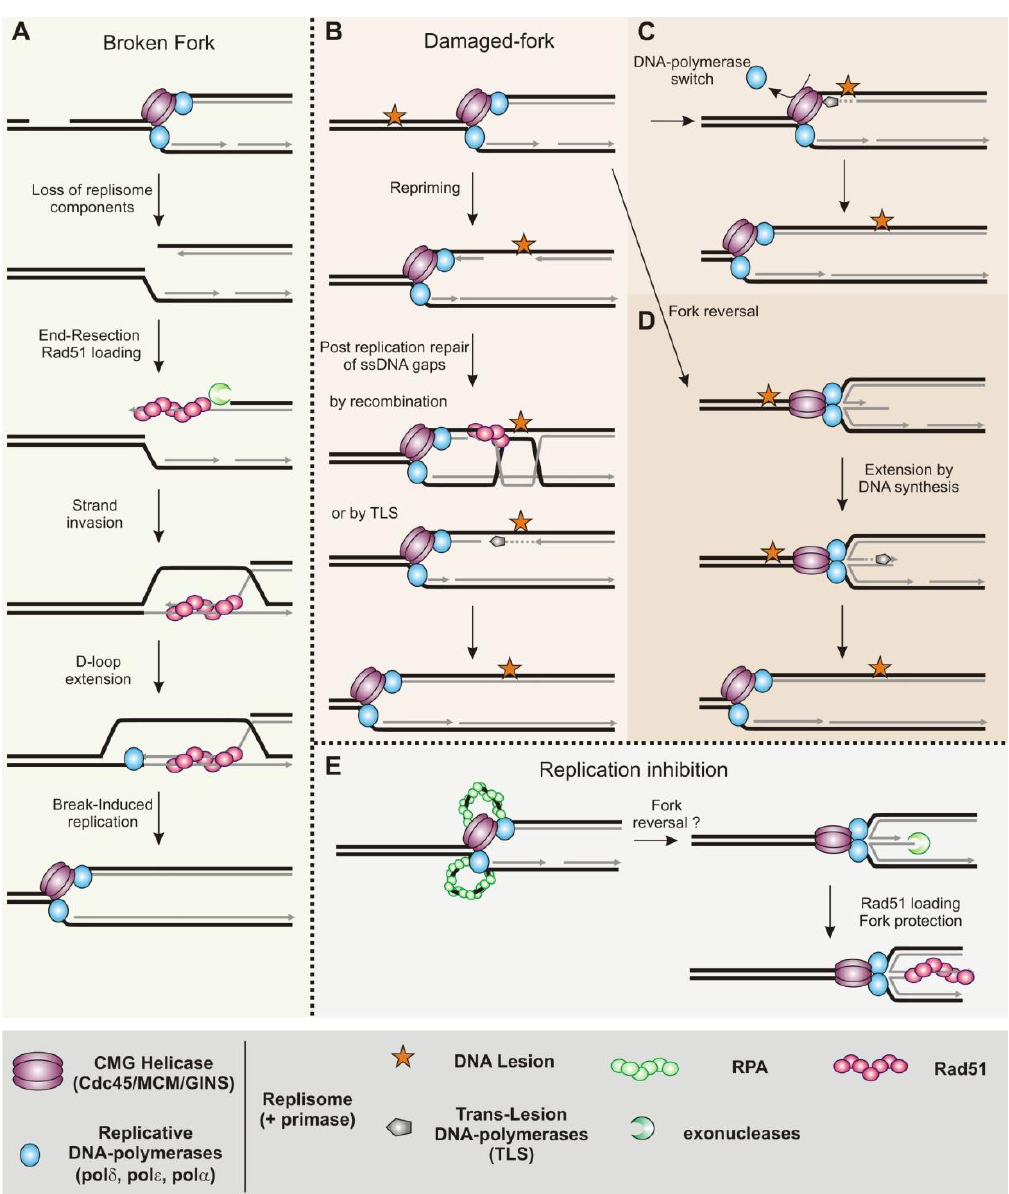
Figure 3. Recombination function at replication forks in eukaryotes (see text for details). ( A )Model of repair of broken forks. ( B ) Model of post-replication repair of ssDNA gaps left behind moving forks. ( C ) Model of polymerase-switch at damaged-forks (recombination independent). ( D ) Model of fork reversal at damaged forks (the role of recombination in this pathway remains unclear). ( E ) Model of fork-stabilization upon inhibition of the elongation step, without a strand exchange step by the